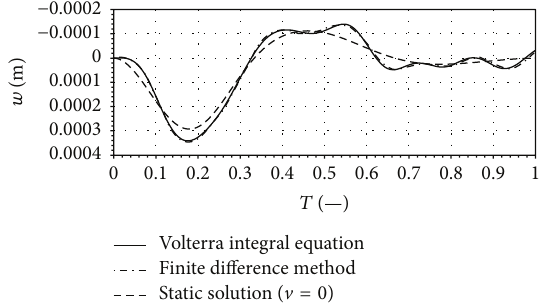
Figure 17: Dynamic deflection of point “a” due to a moving force.